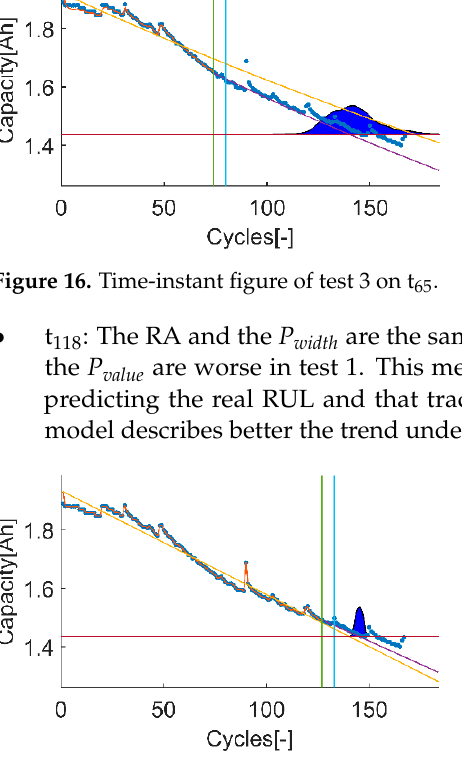
Figure 17. Time-instant figure of test 1 on t 118 .